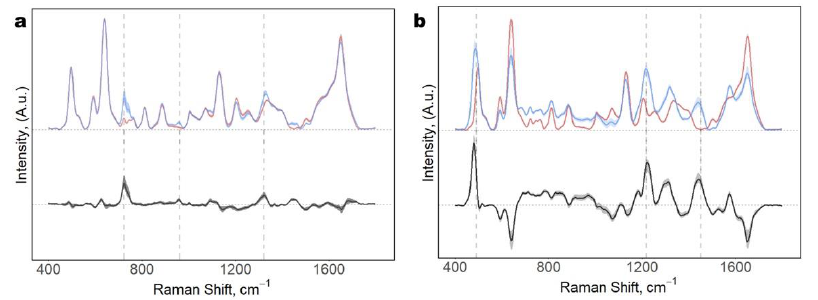
Figure 7. SERS spectra of serum samples spiked with pure metabolites. ( a ) top, over imposed spectra of serum (red) and serum + 50 μM HX (blue); bottom, difference spectrum HX-serum. ( b ) top, over of serum (red) and serum + 50 µ M HX (blue); bottom, difference spectrum HX-serum. ( b ) top, imposed spectra of serum (red) and serum + 25 μM ERG (blue); bottom, difference spectrum ERG- over imposed spectra of serum (red) and serum + 25 µ M ERG (blue); bottom, difference spectrum serum.